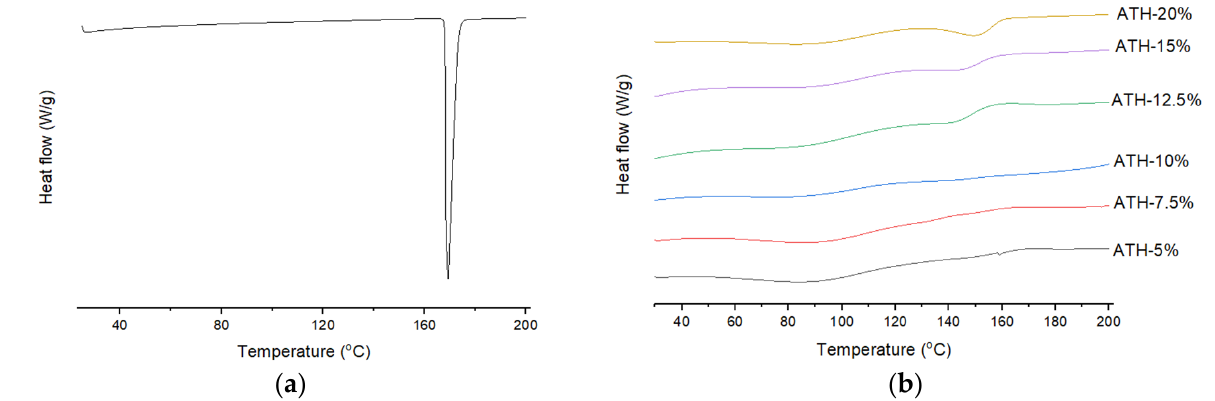
Figure 5. DSC (differential scanning calorimetry) thermograms of: ( a ) pure ATH prior to printing, and ( b ) the DLP 3D-printed tablets with different amounts of ATH.